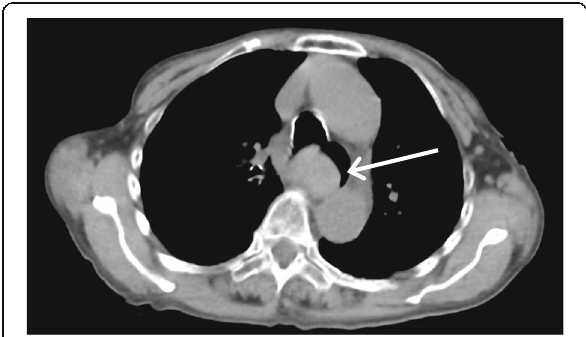
Fig. 1 Computed tomography thoracic examination immediately after hematemesis. The thoracic oesophagus is dilated. The white arrow indicates the